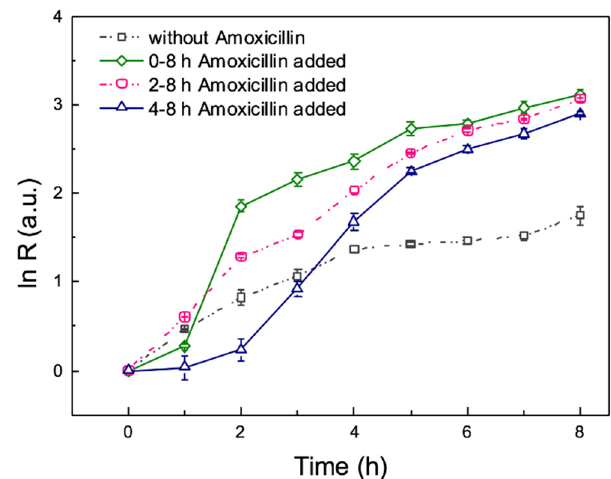
Figure 6. E ff ect of antibiotic on mixed microorganism for on-chip culture. Mixed strains microorganism Figure 6. Effect of antibiotic on mixed microorganism for on-chip culture. Mixed strains from the sludge of secondary sedimentation tank were cultured in pretreated piggery water, and 4 microorganism from the sludge of secondary sedimentation tank were cultured in pretreated mg / L amoxicillin were added after 0, 1, 3 h incubation. Error bars are standard piggery water, and 4 mg/L amoxicillin were added after 0, 1, 3 h incubation. Error bars are standard deviations.